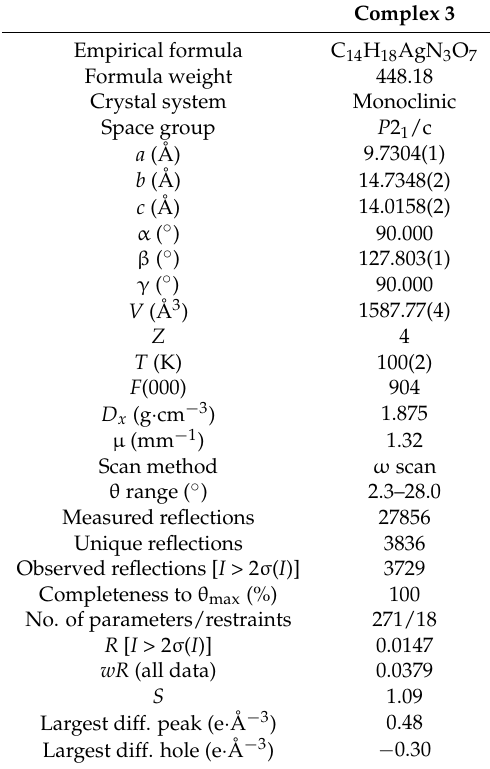
Table 2. Crystallographic data for 3